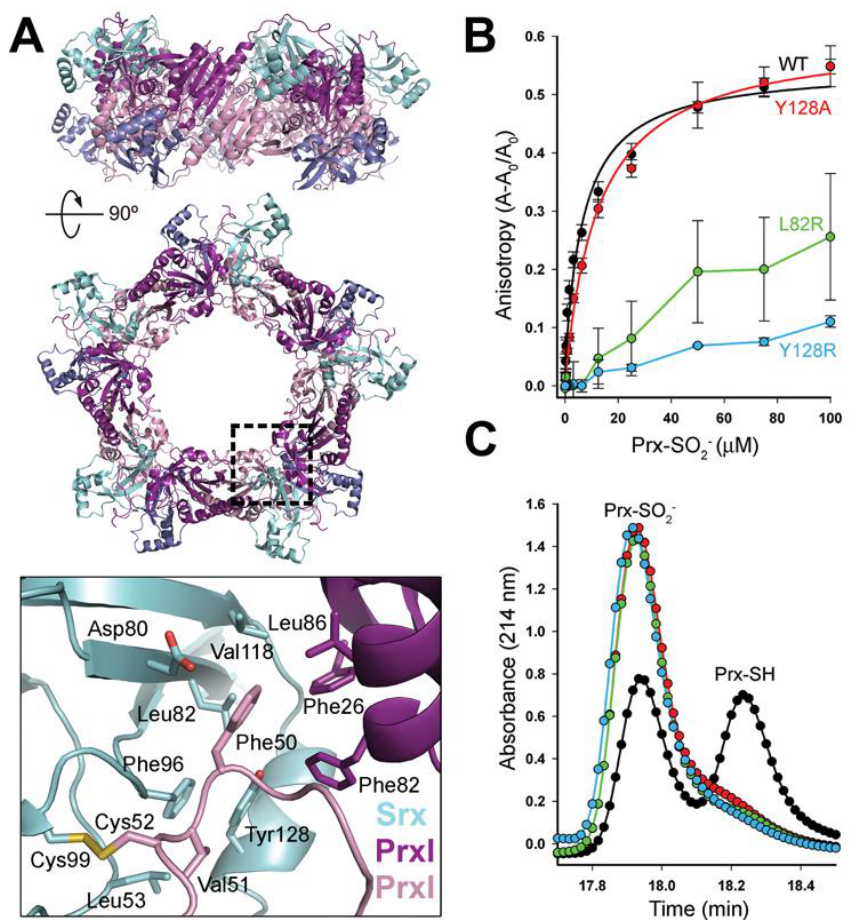
Figure 3. Adjacent Prx molecule at the dimer-dimer interface contributes to the Prx-binding pocket of Srx. ( A ) Cartoon representation of the Srx-Prx1 complex in orthogonal views; same coloring used as in Figure 2. The lower panel shows details of the dimer–dimer interface proximal to the Srx active site, indicated by the dashed box in the upper panel. Phe50 of Prx1 (violet) interacts with a hydrophobic pocket (cyan) formed by Leu53, Asp80, Leu82, Phe96, Val118, and Tyr128 of Srx. The Prx1 subunit (purple) from a neighboring dimer in the decamer contributes Phe26, Phe82 and Leu86. ( B ) Biochemical analysis of Srx variants within the Phe50 binding pocket. Srx interactions measured in solution by changes in fluorescence anisotropy with Oregon Green 514-labelled Srx variants. The data are expressed as the fractional change in anisotropy, (A − A 0 )/A 0 , versus the concentration of decameric Prx1-SO 2 H added, with the error bars indicating s.d. ( C ), Representative HPLC traces from the activity analysis of Srx variants; 30 min time point shown. Repair of the Prx1-SO 2 H moiety by WT Srx leads to a marked shift to a later elution time.